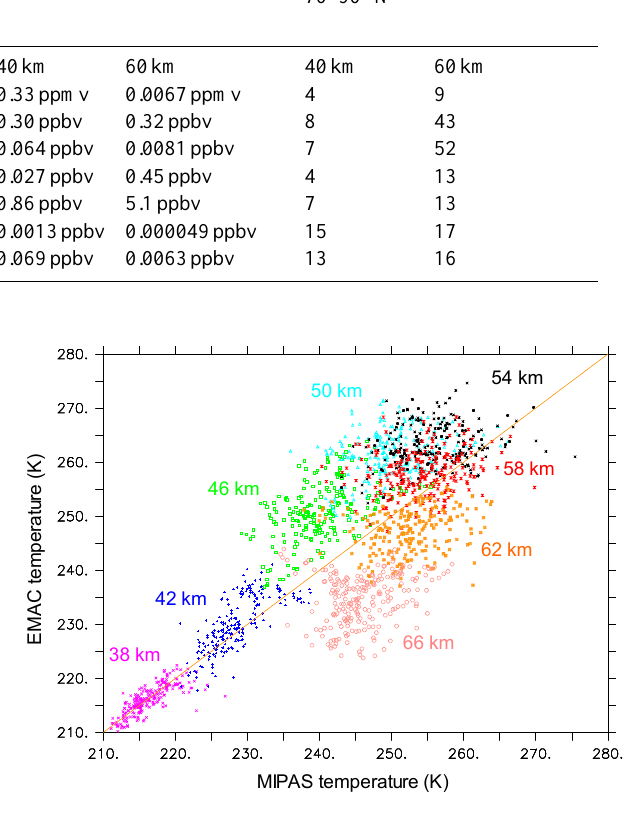
Table 2. MIPAS measurement error contributions and vertical resolution. Single profile precision for 70–90 ◦ N; given in